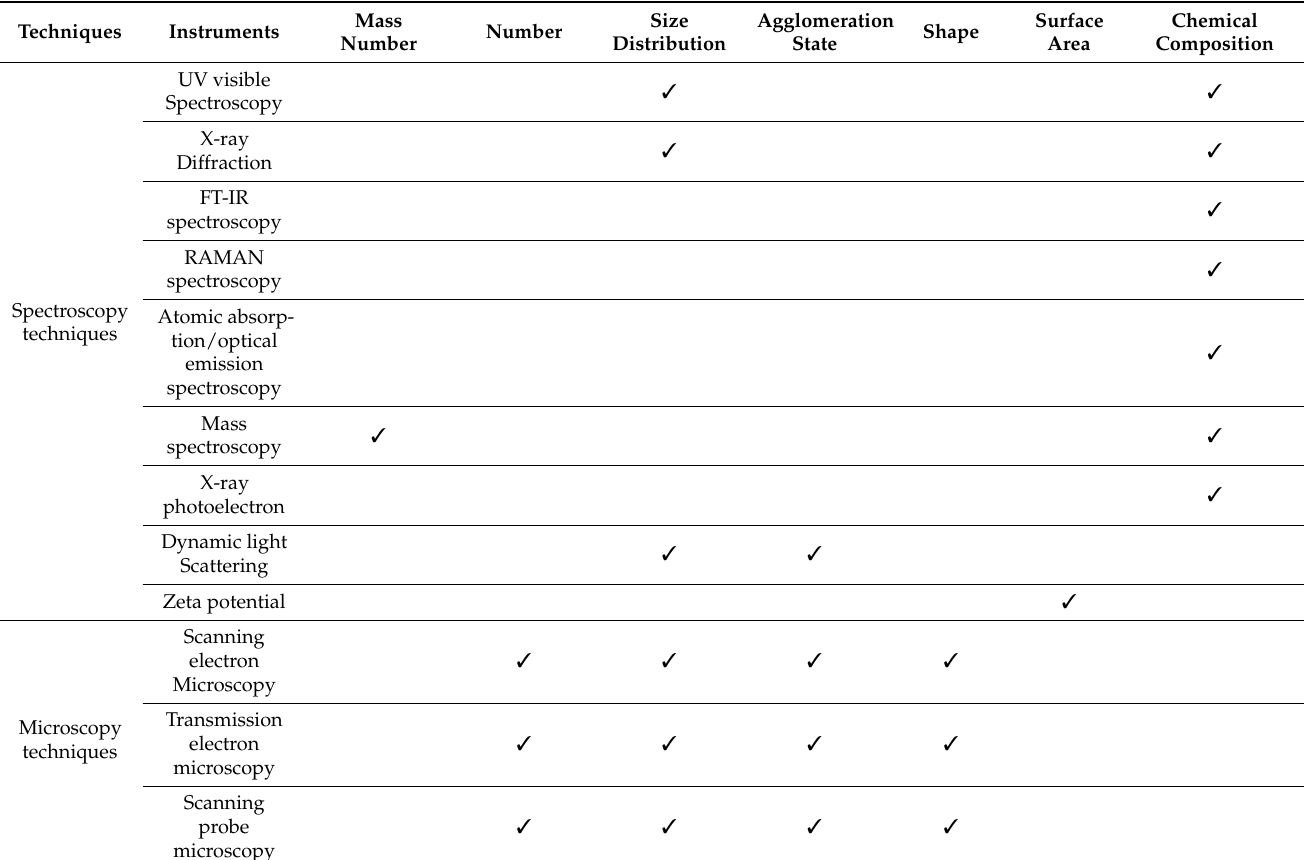
Table 1. An overview of techniques to characterize physicochemical properties of